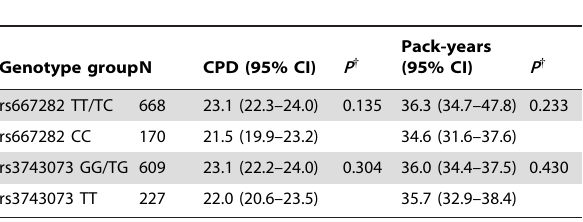
Table 5. Association between 2 SNPs genotype groups with cigarettes per day (CPD) and pack-years in all smoking participants.